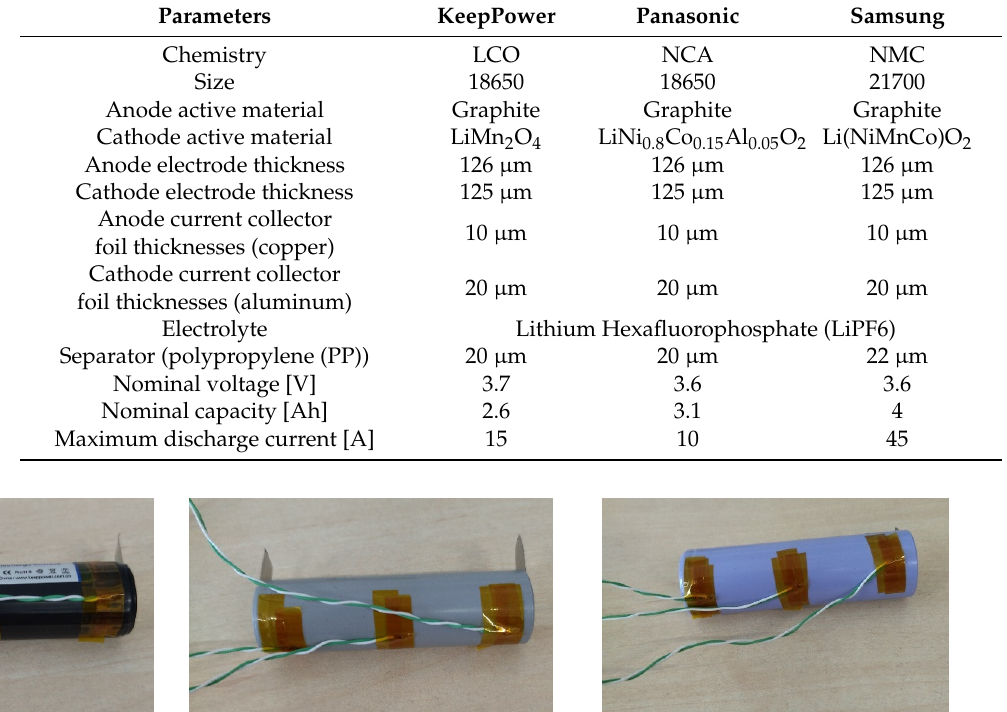
Table 1. Battery cell parameters.